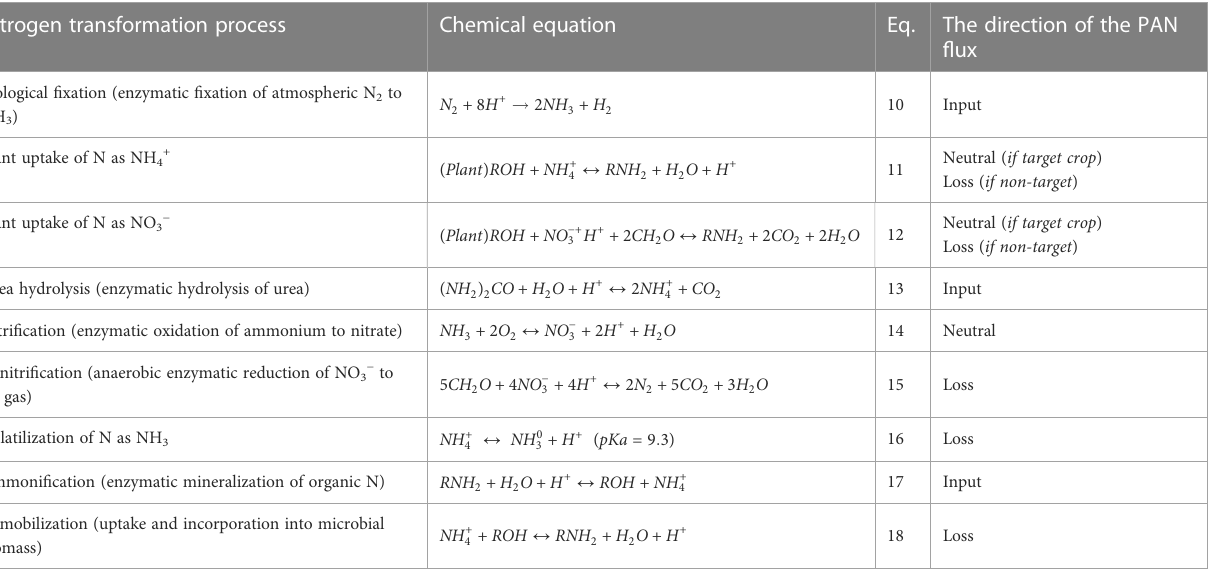
TABLE 1 Nitrogen transformation